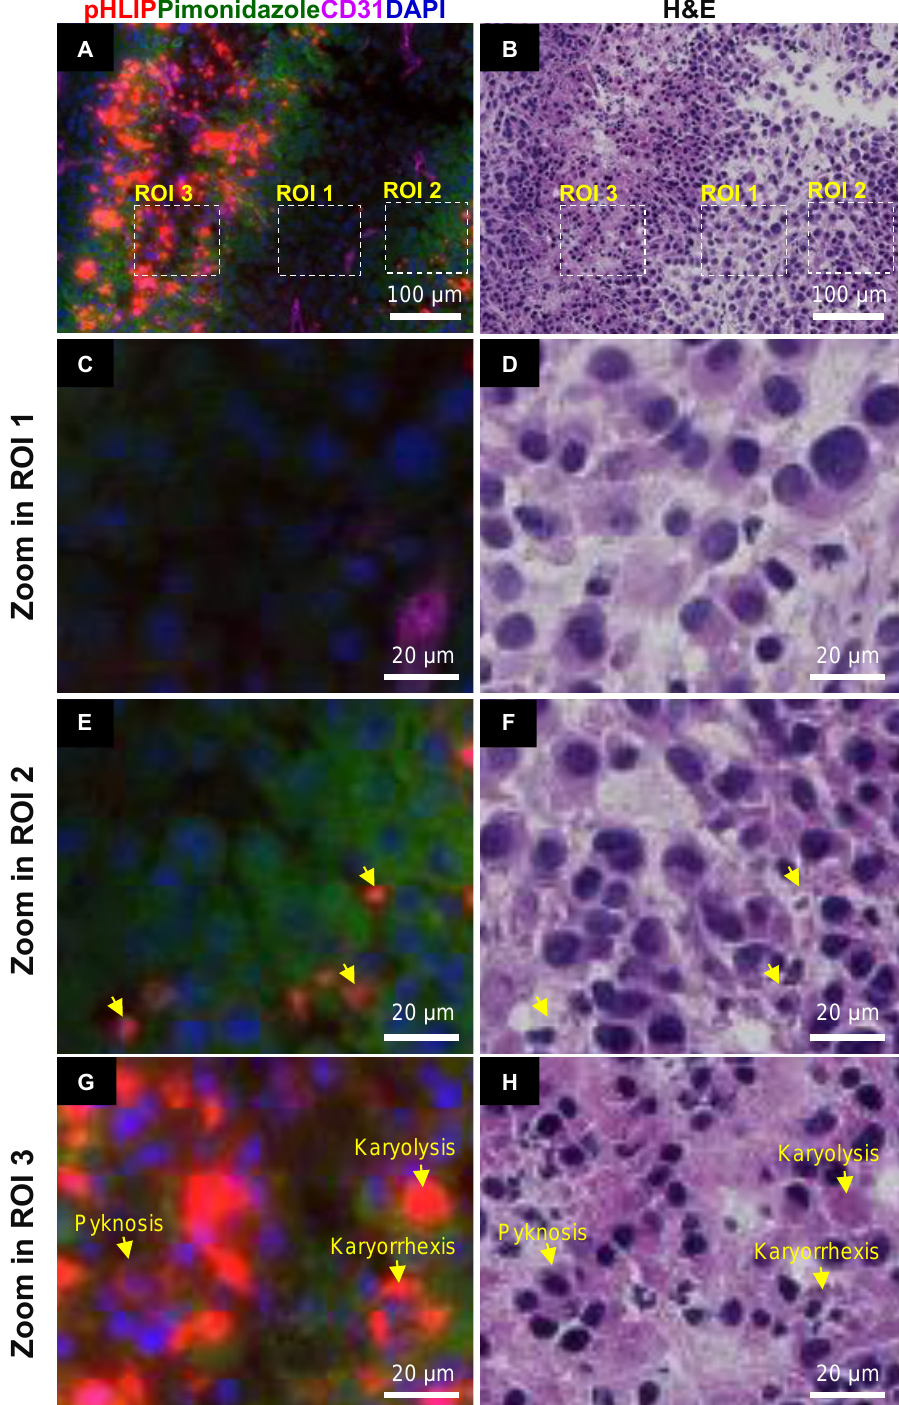
Figure 5. pHLIP localization at the cellular level. ( A ) An overlay image of pHLIP distribution (AF546-pHLIP, red), pimonidazole-stained hypoxia (green), CD31-stained microvessels (magenta), and DAPI-stained nuclei (blue). ( B ) The corresponding hematoxylin and eosin staining in the same site of the same section of a U87MG tumor. ( C , E , G ) denote enlarged views of ROI-1, -2, and -3 of ( A ), respectively. ( D , F , H ) depict enlarged views of ROI-1, -2, and -3 of ( B ), respectively. ROI 1, normoxic region; ROI 2, hypoxic region; ROI 3, necrotic region. Yellow arrows in ( E , F ) mark the pHLIP signals in the extracellular space. Pyknosis, karyorrhexis, and karyolysis in ( G , H ) clearly show the necrotic cells with shrunken, fragmented, and dissolved nuclei, respectively.